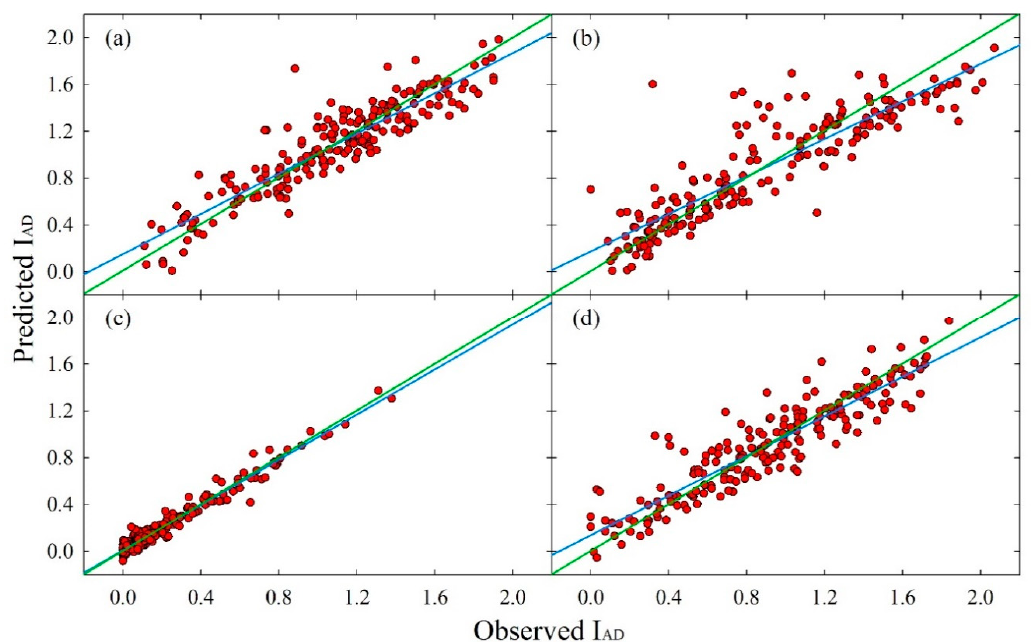
Figure 4. Scatter plots of cross-validation predicted I AD against observed I AD in yellow peach fruit ( n = 200) using a partial least square regression (PLS) model: ( a ) ‘August Flame’; ( b ) ‘O’Henry’; ( c ) ‘Redhaven’ and ( d ) ‘September Sun’. Blue lines represent partial least square regression model linear fits; green lines represent reference linear fits where predicted I AD = observed I AD . PLS statistics are reported in Table